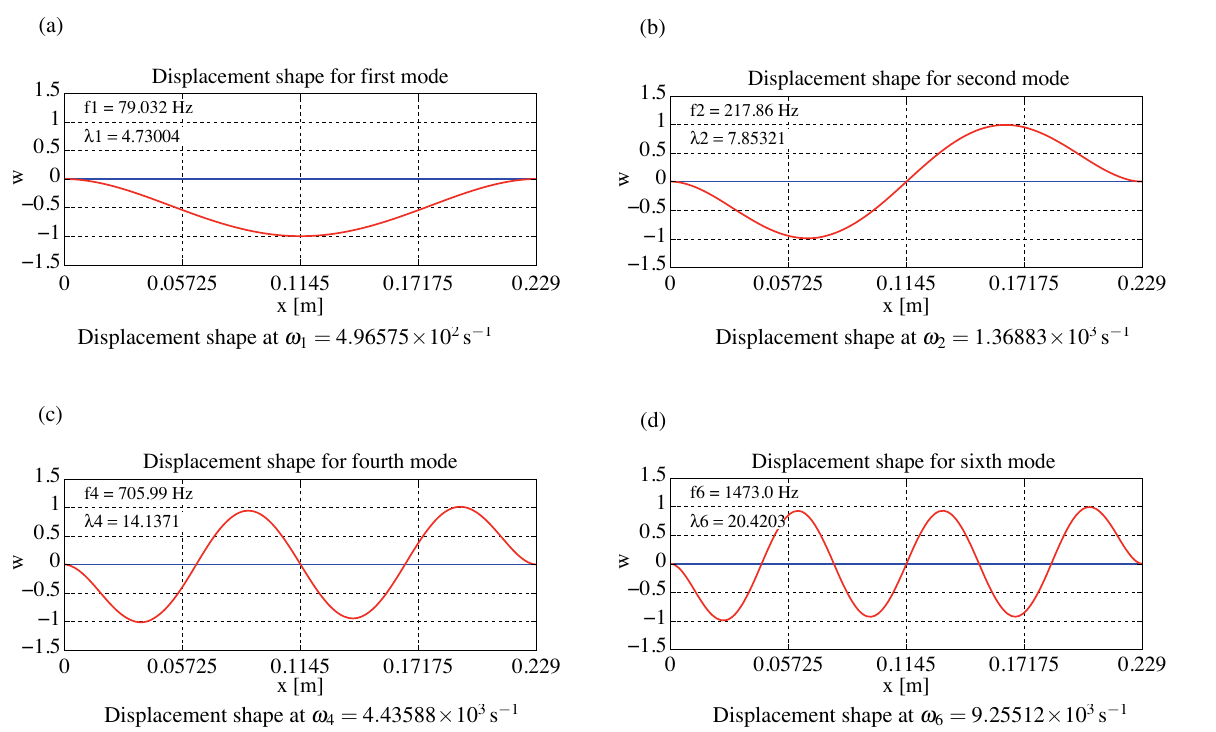
Fig. 9. Transversal displacement shapes of fixed-fixed beam modes.